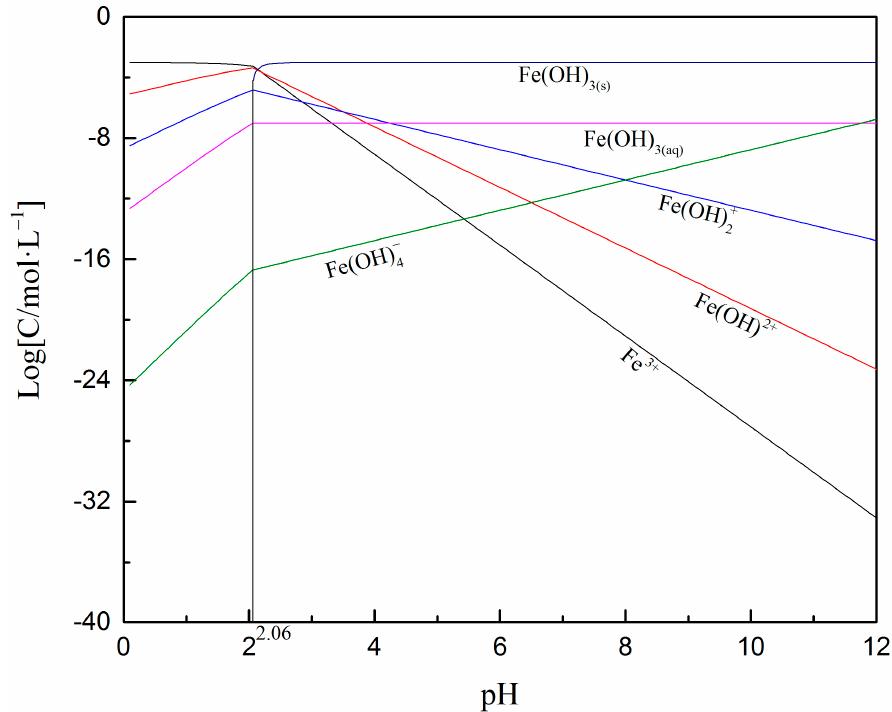
Figure 6. Species distribution diagram of 1 × 10 − 3 mol/L Fe 3+ in the solution as a function of pH [29].